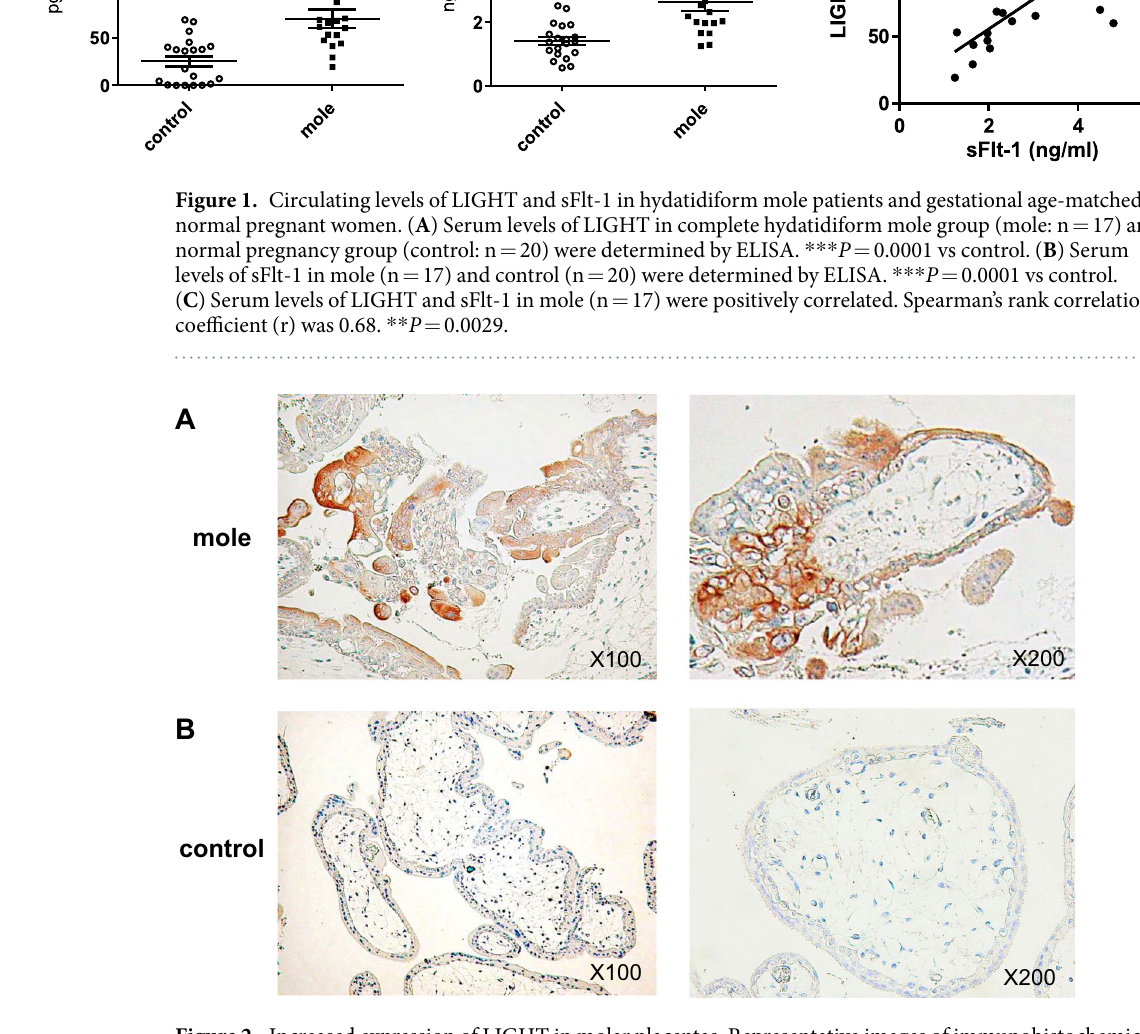
Figure 2. Increased expression of LIGHT in molar placentas. Representative images of immunohistochemical staining for LIGHT in the placenta of a hydatidiform mole case ( A ) and normal control ( B ) are